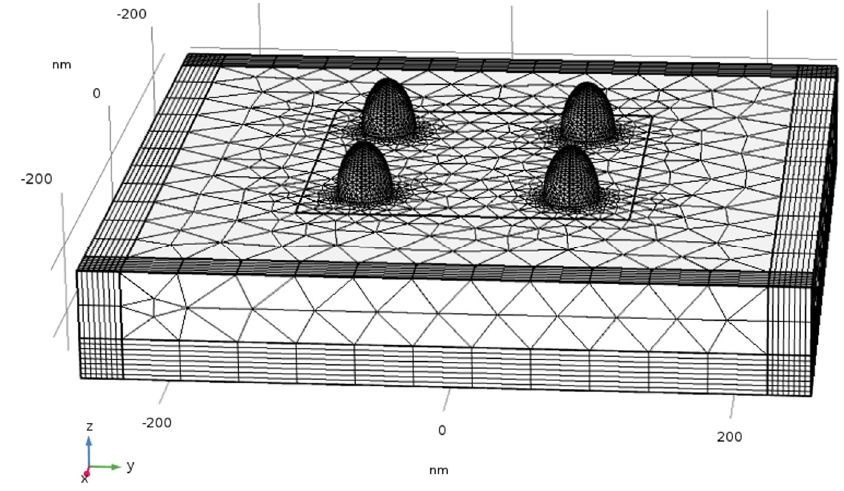
Figure 19. Simulation configuration of neighboring silver hemi-spheroid.